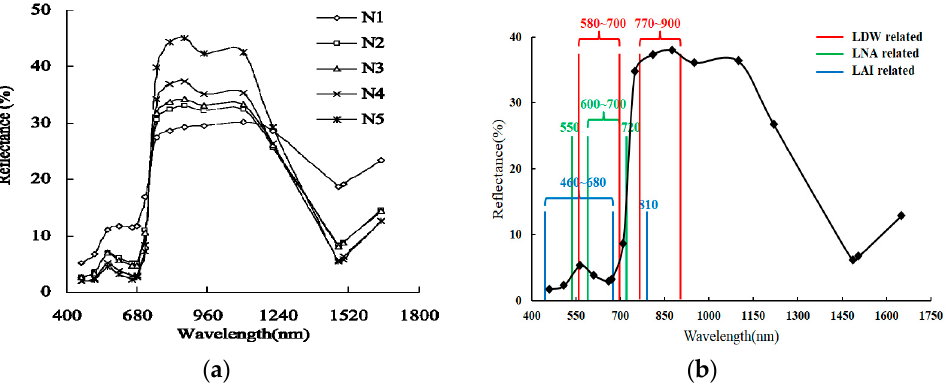
Figure 1. Characteristic curve of the spectral reflectivity of wheat canopy. ( a ) Multispectral reflectivity of wheat canopy under application of different amounts of nitrogen, and ( b ) characteristic spectral bands of agronomic wheat parameters.